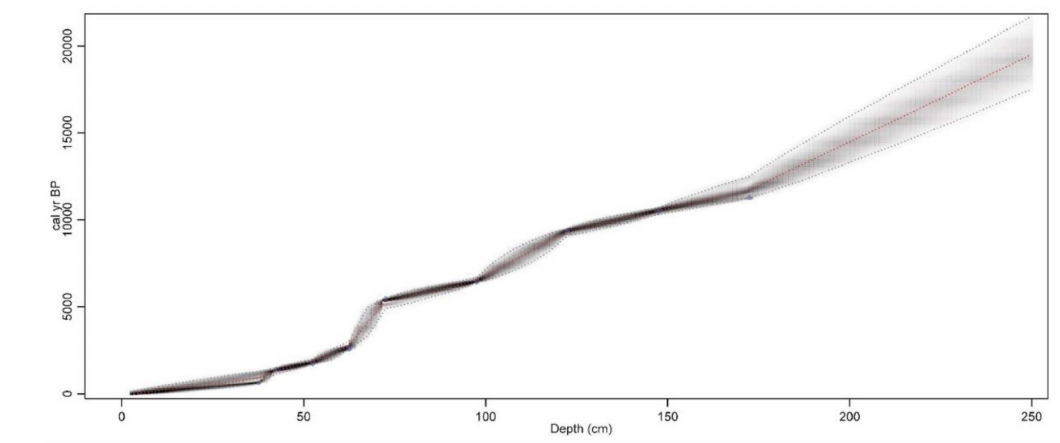
Figure 9. The age-depth model of the soil profile, with the 2 σ error envelope of the calibrated